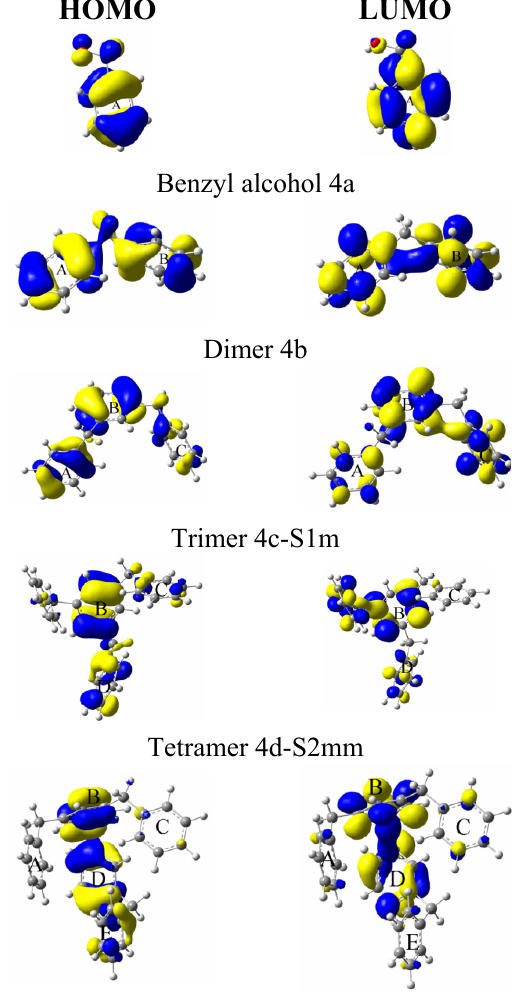
Figure 4. The highest occupied and lowest unoccupied molecular